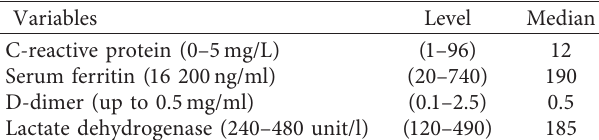
Table 3: Laboratory parameters of group A.